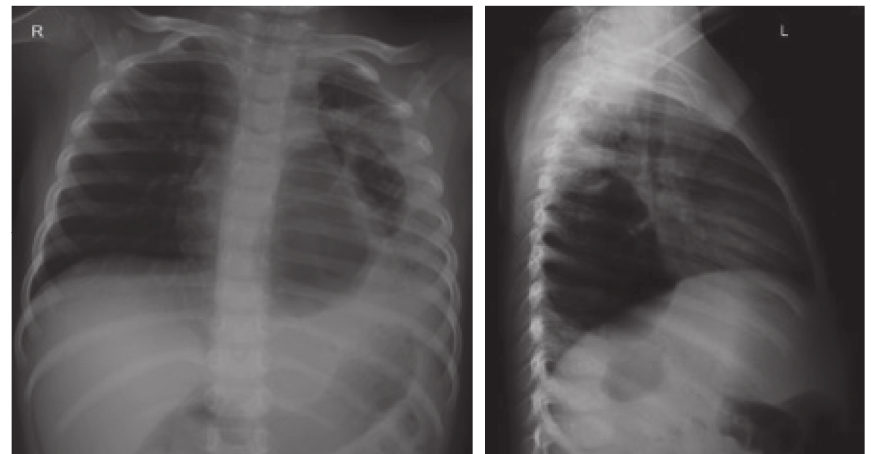
Figure 3: CXR AP and lateral view showing an air-filled cavitary lesion in the infero-posterior left lobe.